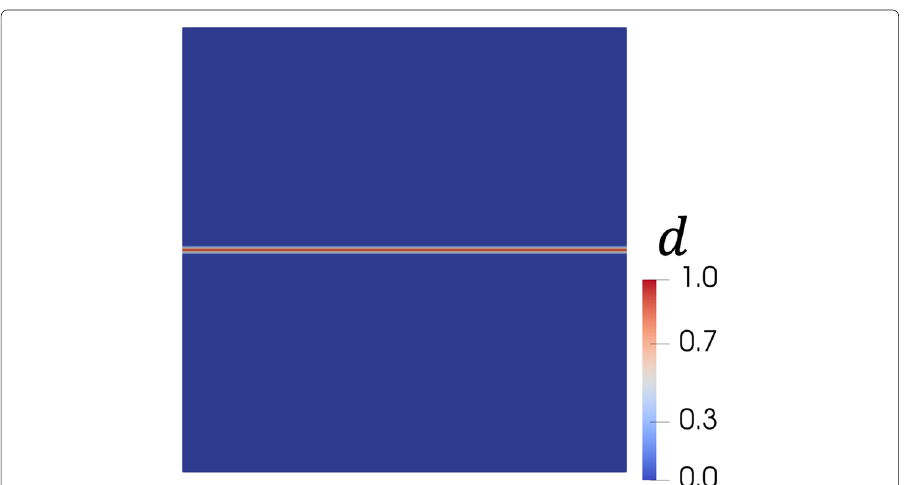
Fig. 1 The domain used to investigate the mechanical response of the cracked material under tension, compression and shear loads. The square domain is 1 mm by 1 mm and the horizontal crack is 0.5 mm from the bottom surface. The domain is shaded by the d field